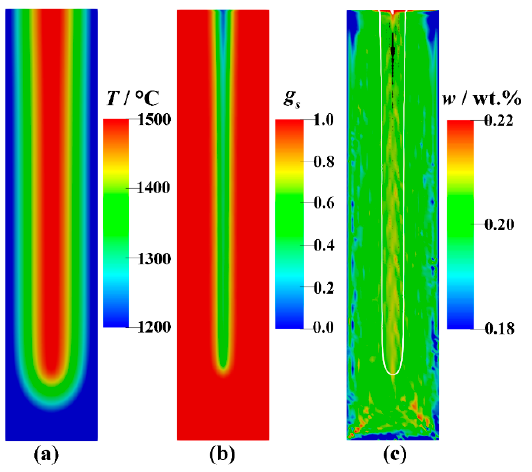
Figure 5. The predicted temperature ( a ), solid volume fraction ( b ), liquid velocity, and C concentration ( c ) of the steel ingot at the solidification time t = 700 s. The two white lines in ( c ) represent the solid volume fraction contours of 0.1 and 0.9. The velocity vector zoomed 2000 times is indicated.